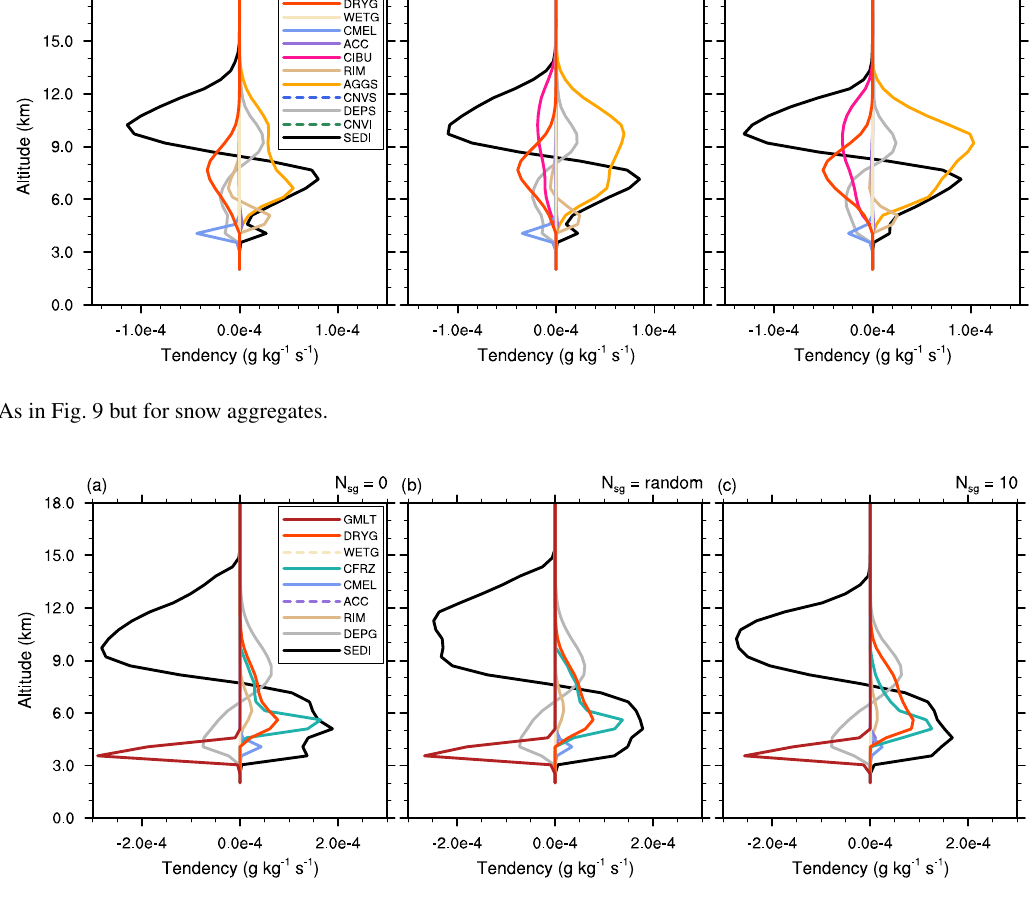
Figure 11. As in Fig. 9 but for graupel.